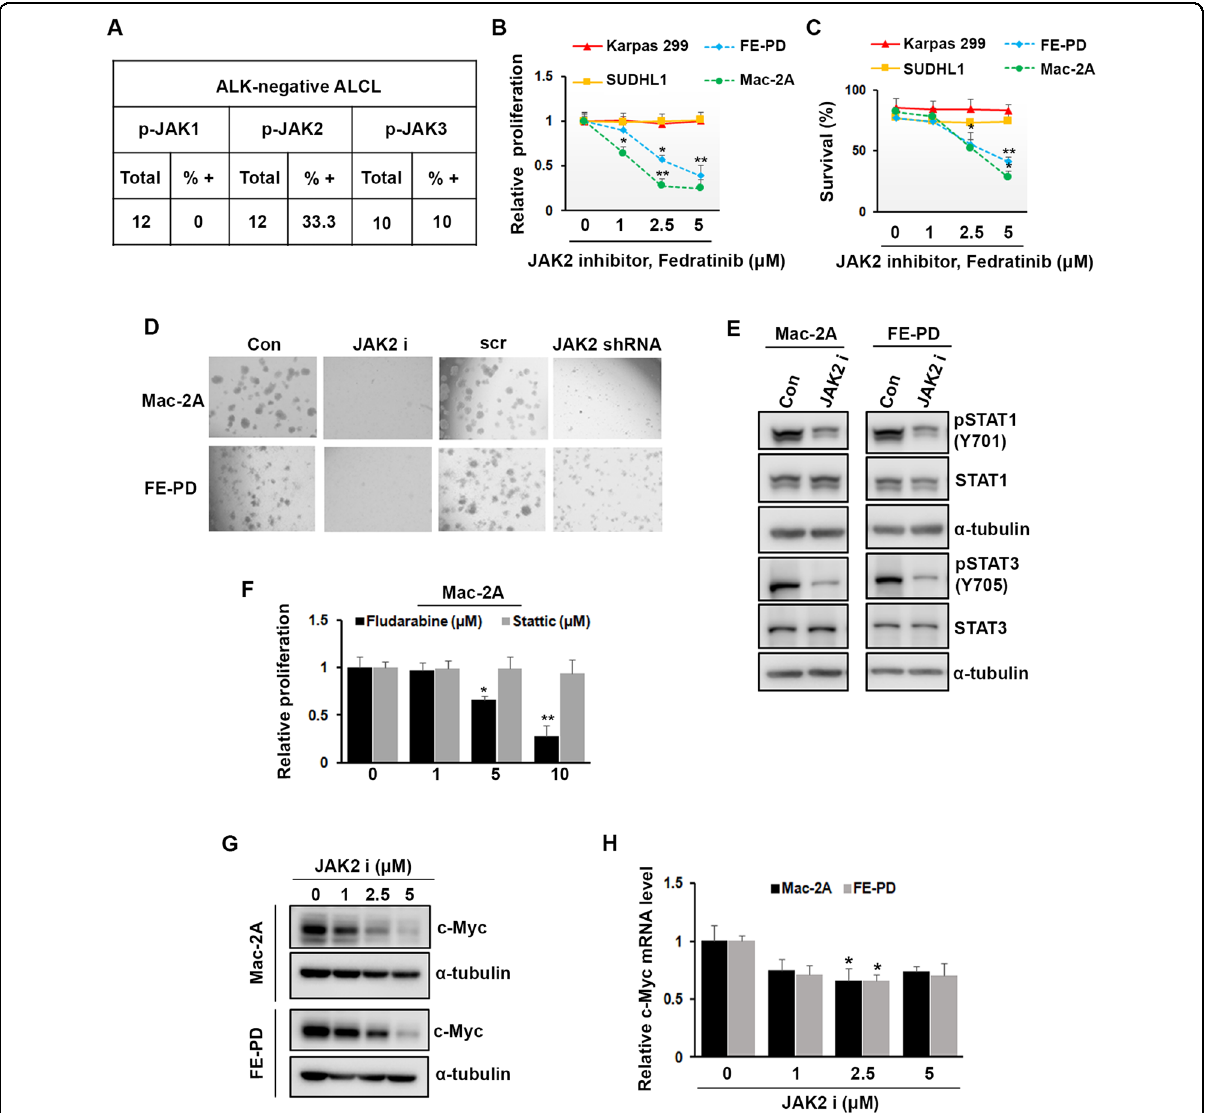
Fig. 1 JAK2 regulates ALK-negative ALCL cell growth via STAT1/c-Myc signaling. A Summary of pJAK1, pJAK2, and pJAK3 staining by IHC in ALK-negative ALCL tissues by IHC. B – C ALK-negative (Mac-2A and FE-PD) and ALK + ALCL cell lines (Karpas 299 and SUDHL1) were treated with the indicated fedratinib, and proliferation/survival was assessed (* P < 0.05, ** P < 0.01). D Mac-2A and FE-PD cells were plated in semisolid Metho-Cult medium left untreated and treated with fedratinib or JAK2 shRNA, and the colony numbers were scored after 10 days. E Mac-2A and FE-PD cells were treated with fedratinib (2.5 μ M) for 24 h and then blotted with pSTAT1 (Tyr701) and pSTAT3 (Tyr705) antibodies. F Mac-2A cells were treated with the indicated concentration of fl udarabine (STAT1 inhibitor) or Stattic (STAT3 inhibitor) for 72 h and proliferation was assessed by MTT assay (* P < 0.05, ** P < 0.01). G – H Mac-2A and FE-PD cells were treated with indicated concentration of fedratinib for 48 h and protein level of c-Myc ( G ) and mRNA level of c-Myc ( H ) was assessed by western blotting and QRT-PCR respectively (* P <